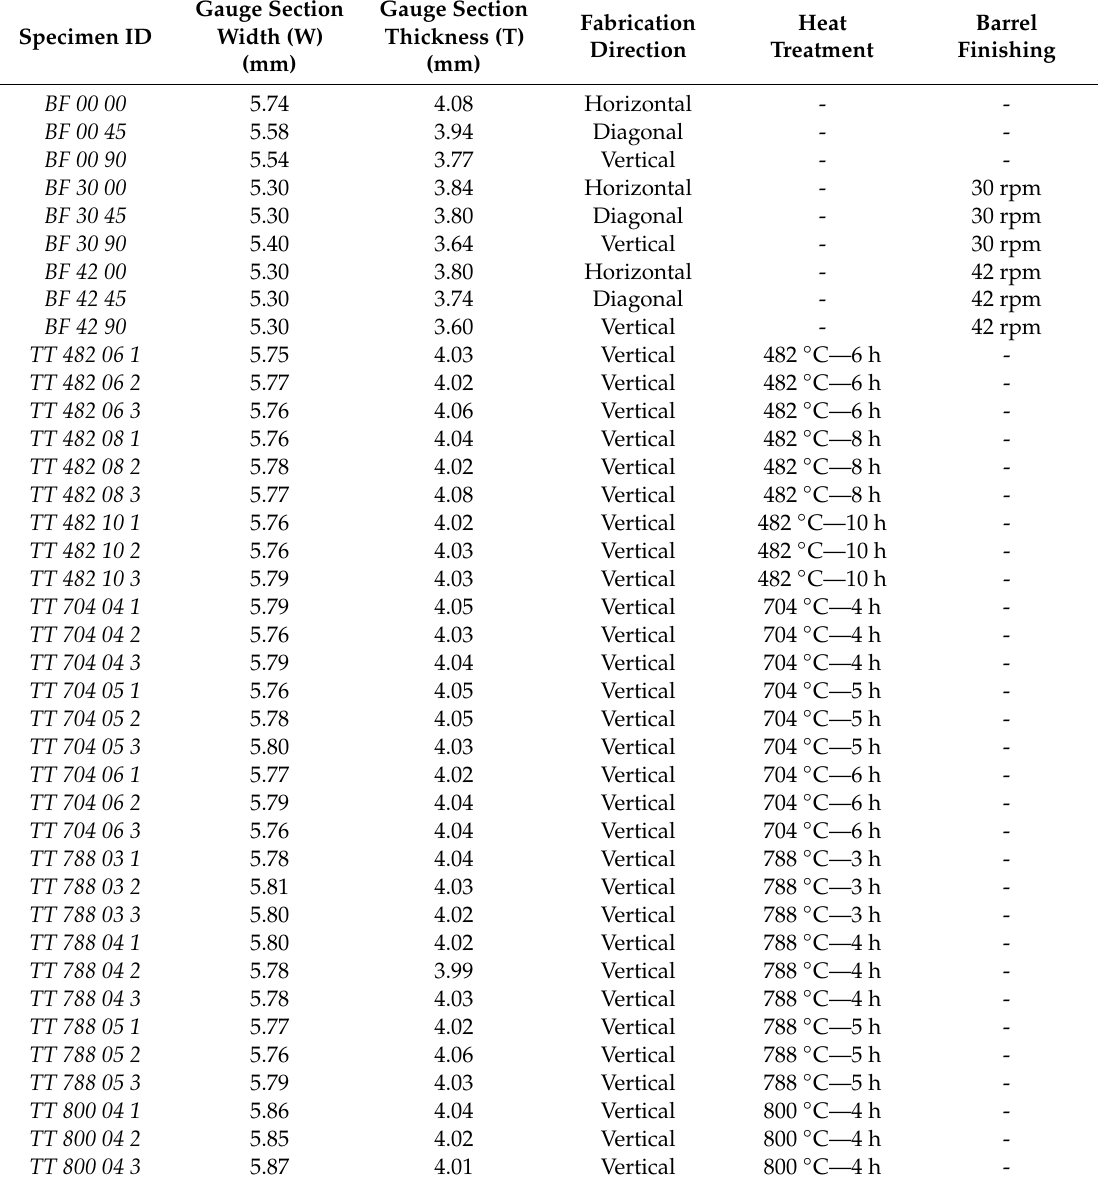
Table 3. Specimens IDs, actual dimensions and postprocessing